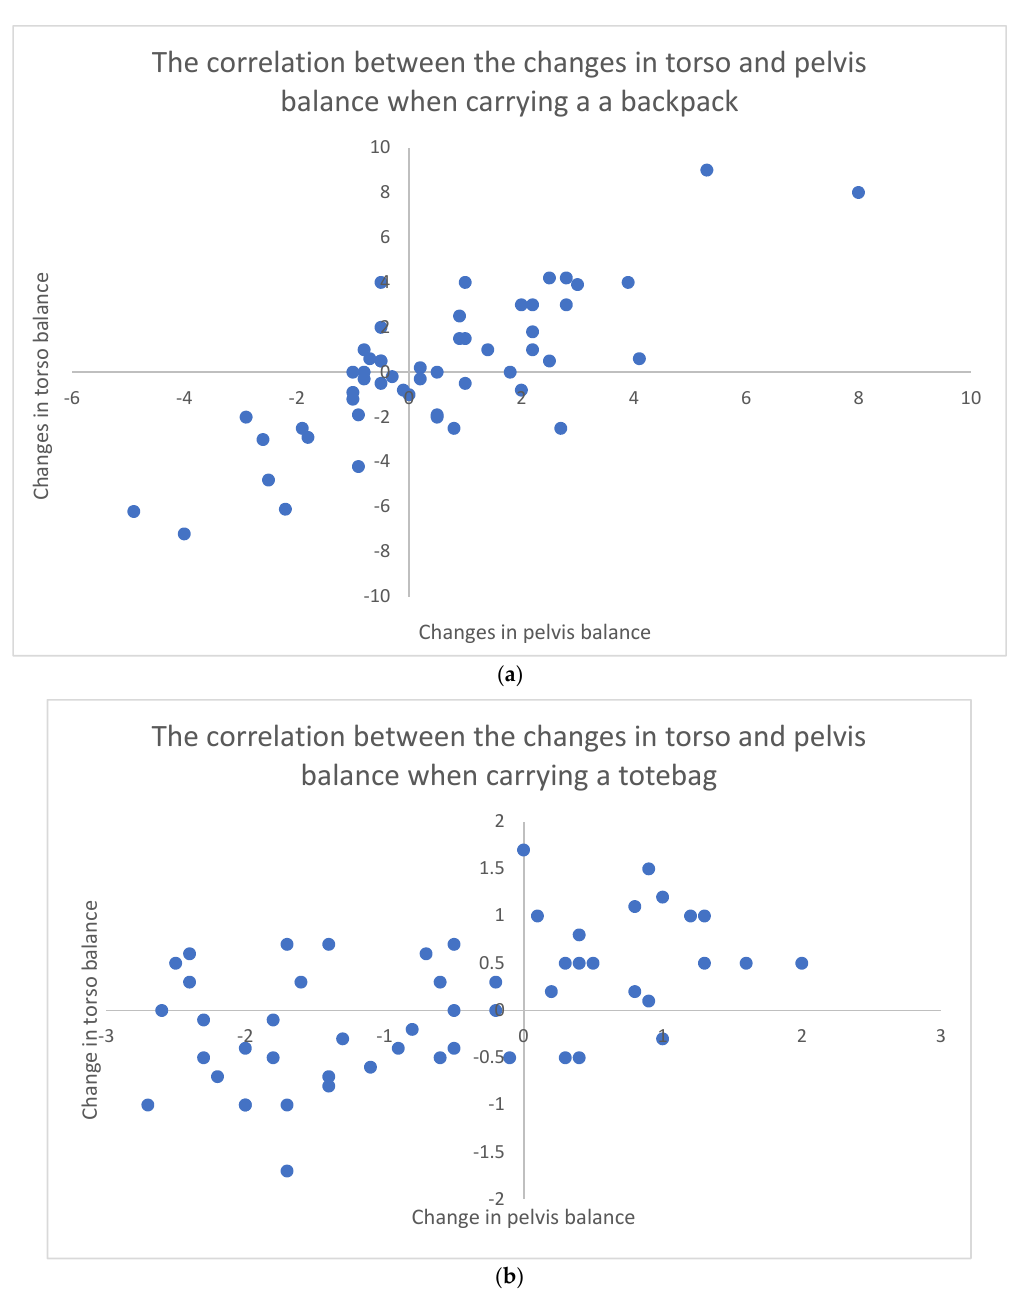
16 of 24 Figure 7. ( a ) The correlation of forefoot pressure (kPa) and weight (R = 0.13); ( b ) the correla- tion of rearfoot pressure (kPa) and weight (R = 0.16); ( c ) the correlation of forefoot pressure (kPa) and height (R = 0.16); ( d ) the correlation of rearfoot pressure (kPa) and height (R = 0.13); and ( e ) the tendency of weight bearing on rearfoot and forefoot (R = 0.12). The observations in Figure 7 show no strong correlations (weak correlation with R values close to zero) between the anthropological parameters (body height and weight) and posture (forefoot and rearfoot pressures). Figure 7a shows a weak negative correla- tion and explains an inverse relationship between the two associated parameters: the bod- yweight increases while the forefoot pressure decreases. Therefore, a lower forefoot pres- sure tends to be associated with higher bodyweight. Figure 7b–e shows the weak positive correlations and the direct relationships between the variables observed. For instance, there is a direct association between the rearfoot pressure and bodyweight and height, respectively, as seen in Figure 7b–d. Furthermore, the slight body inclination towards the higher rearfoot weight-bearing percentile means that the subjects placed more weight on their rearfeet than on their forefeet. Similarly, body posture was analysed by observing the load shift in the torso and pelvic balance on the posture chart. The measurements were conducted in correlation with school bag wearing of a backpack, tote bag, or sling/crossbody bag. The results indi- cated the positive correlations between the shift in the torso and pelvis while carrying the bags.